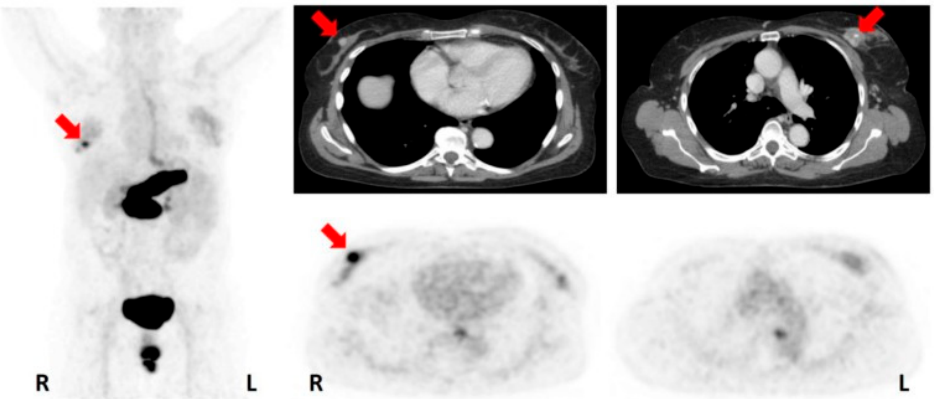
Figure 6. [ 68 Ga]RM2-PET in a patient with bilateral invasive ductal breast carcinoma; the tumor, on the right side was ER/PR positive and showed a strongly positive uptake, while the lesion on the left side was ER/PR negative and showed a weak uptake. Pancreas, esophagus, and rectum uptake is physiological. (Unmodified from Stoykow C. et al. (2016)